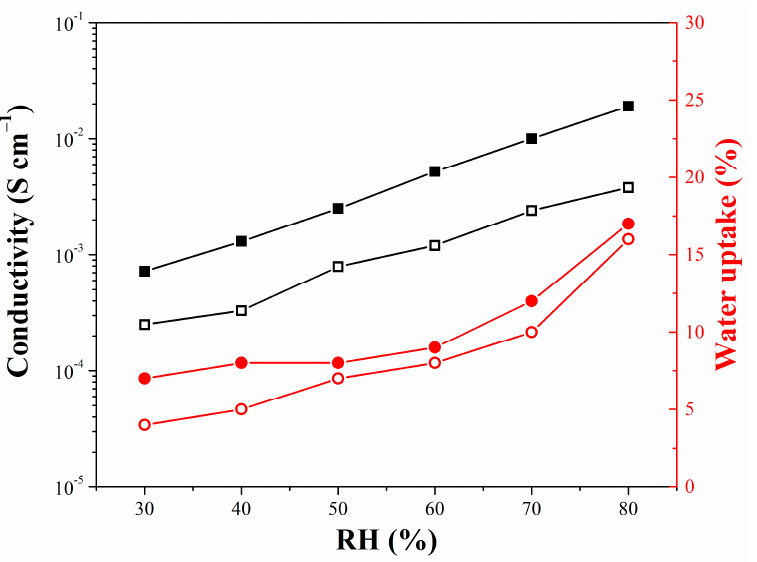
Figure 6. Proton conductivity and water uptake of SPEEK (hollow dots) and SPEEK/DGO/DHNTs/HPW (90/5/5/60) (solid dots) composite membrane at various RHs.